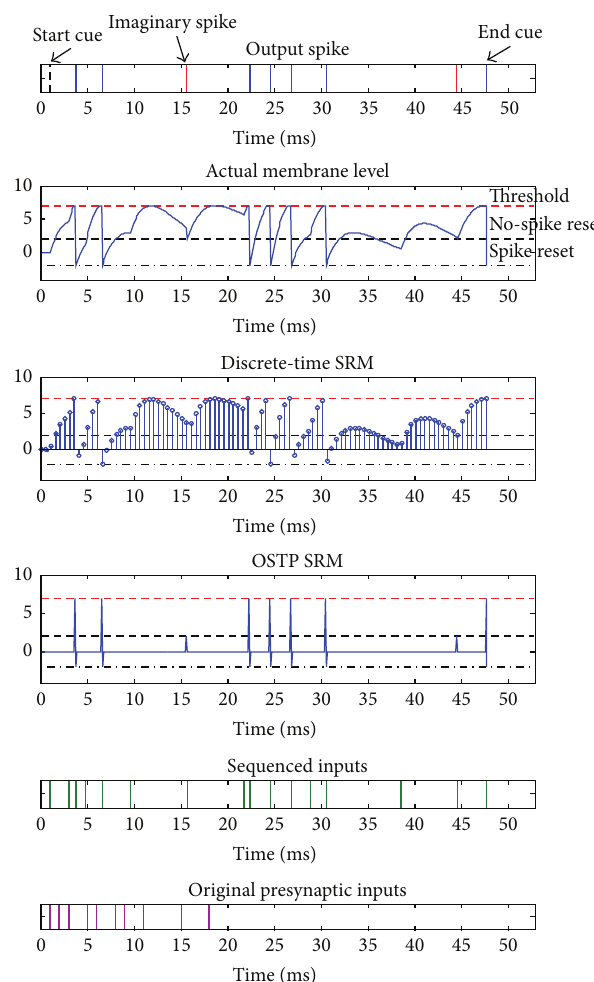
Figure 5: Precise spike firing time at a CD neuron by continuous = 100 ms, providing almost actual membrane level for SRM ( 𝜎 disc = 2 ms), and OSTP SRM comparison), discrete-time SRM ( 𝜎 disc = 10 ) approximation in CD SNN ( 𝜎 OSTP